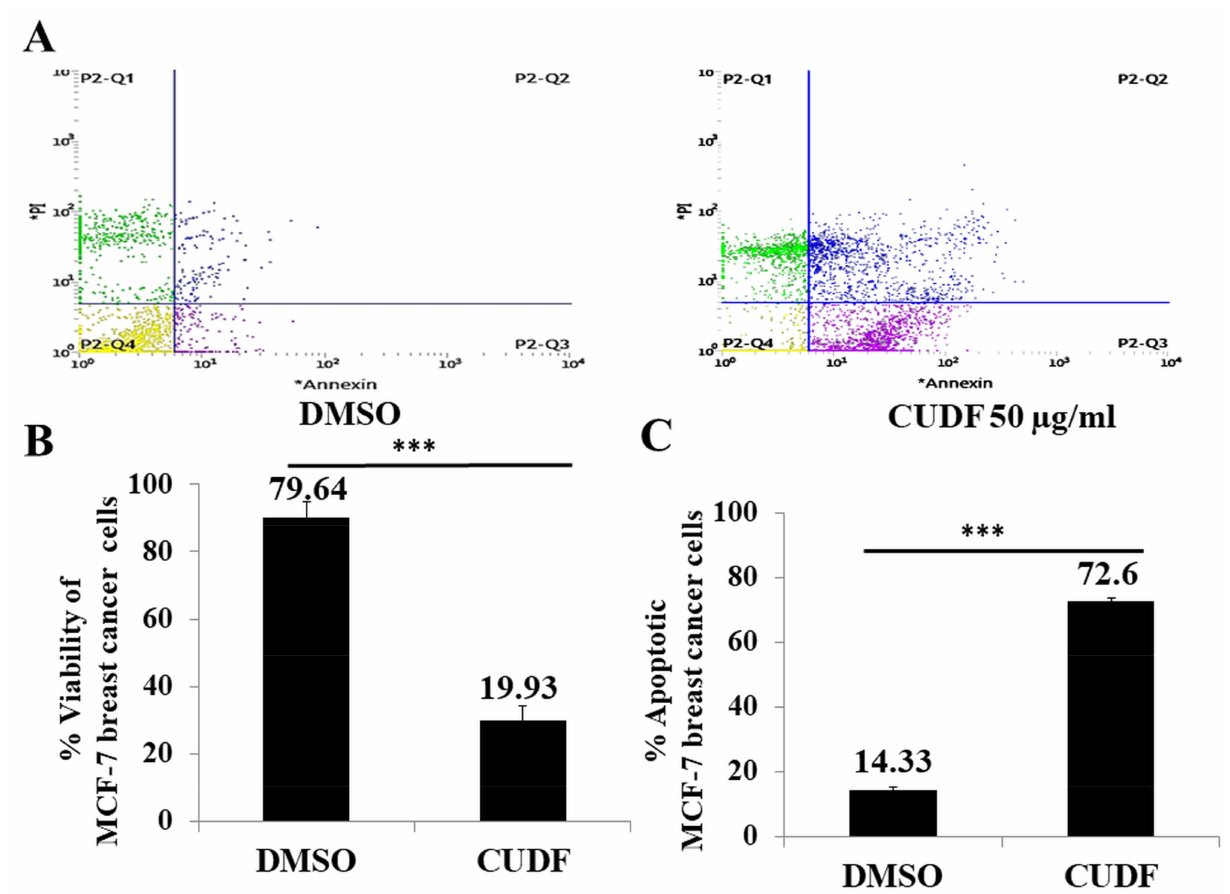
Figure 4. Estimation of CUDF-induced apoptosis in MCF-7 cancer cells. ( A ) MCF-7 cancer cells were treated with DMSO and CUDF (50 µ g/mL) for 72 h. At the end of treatment, harvested MCF-7 cells were subjected to PI/annexin V staining and analyzed by a flow cytometer. The scatter plots of cells were stained with PI and Annexin V conjugated with FITC for analysis of apoptotic cells in MCF-7 cells. ( B ) MCF-7 cancer cells were treated with DMSO and CUDF (50 µ g/mL) for 72 hr. At the end of treatment, harvested MCF-7 cells were subjected to PI/annexin V staining and analyzed with a flow cytometer. The percentage of cell viability was calculated based on the number of PI- and annexin-V-negative cells in quadrant 4 of the scatter plot divided by the total number of cells. ( C ) MCF-7 cancer cells were treated with DMSO and CUDF (50 µ g/mL) for 72 h. At the end of treatment, harvested MCF-7 cells were subjected to PI/annexin V staining and analyzed with a flow cytometer. The percentage of apoptotic cells was calculated based on the number of cells in quadrants 3 and 4 stained with annexin V and PI divided by the total number of cells. Data are represented as mean ± SD. Each experiment was conducted independently three times. *** Significantly different from the DMSO control at a p -value ≤